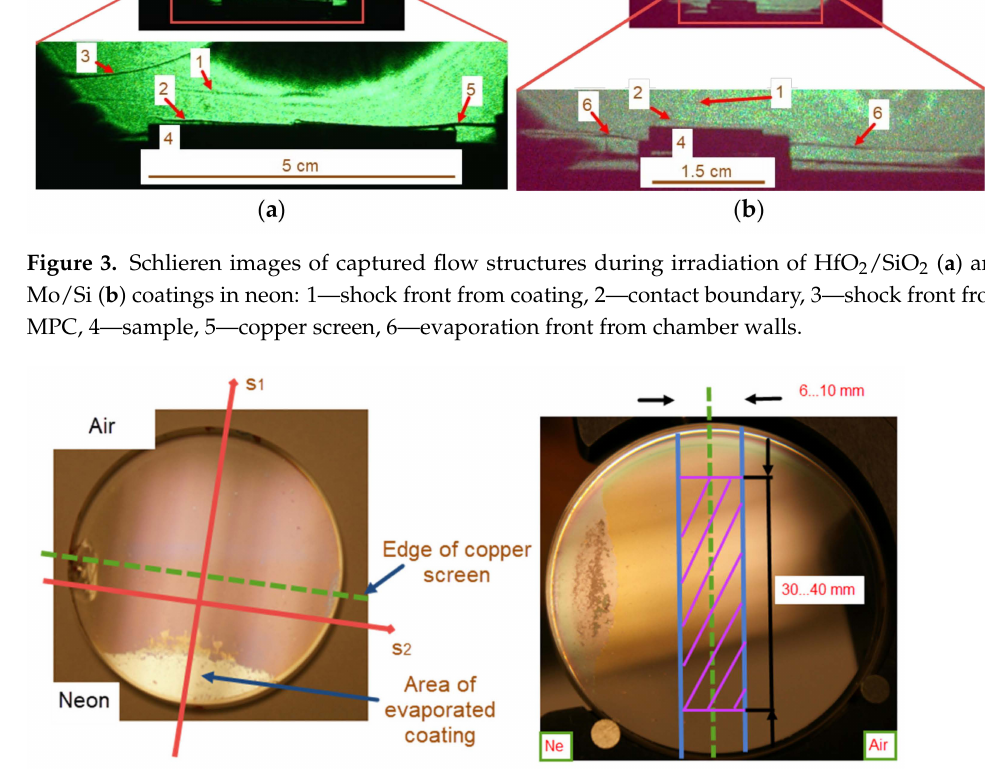
Figure 4. Photos of HfO 2 /SiO 2 multilayer on fused quartz irradiated in neon and air. Parameters were measured in the hatched area. Roughness was measured along s 1 and s 2